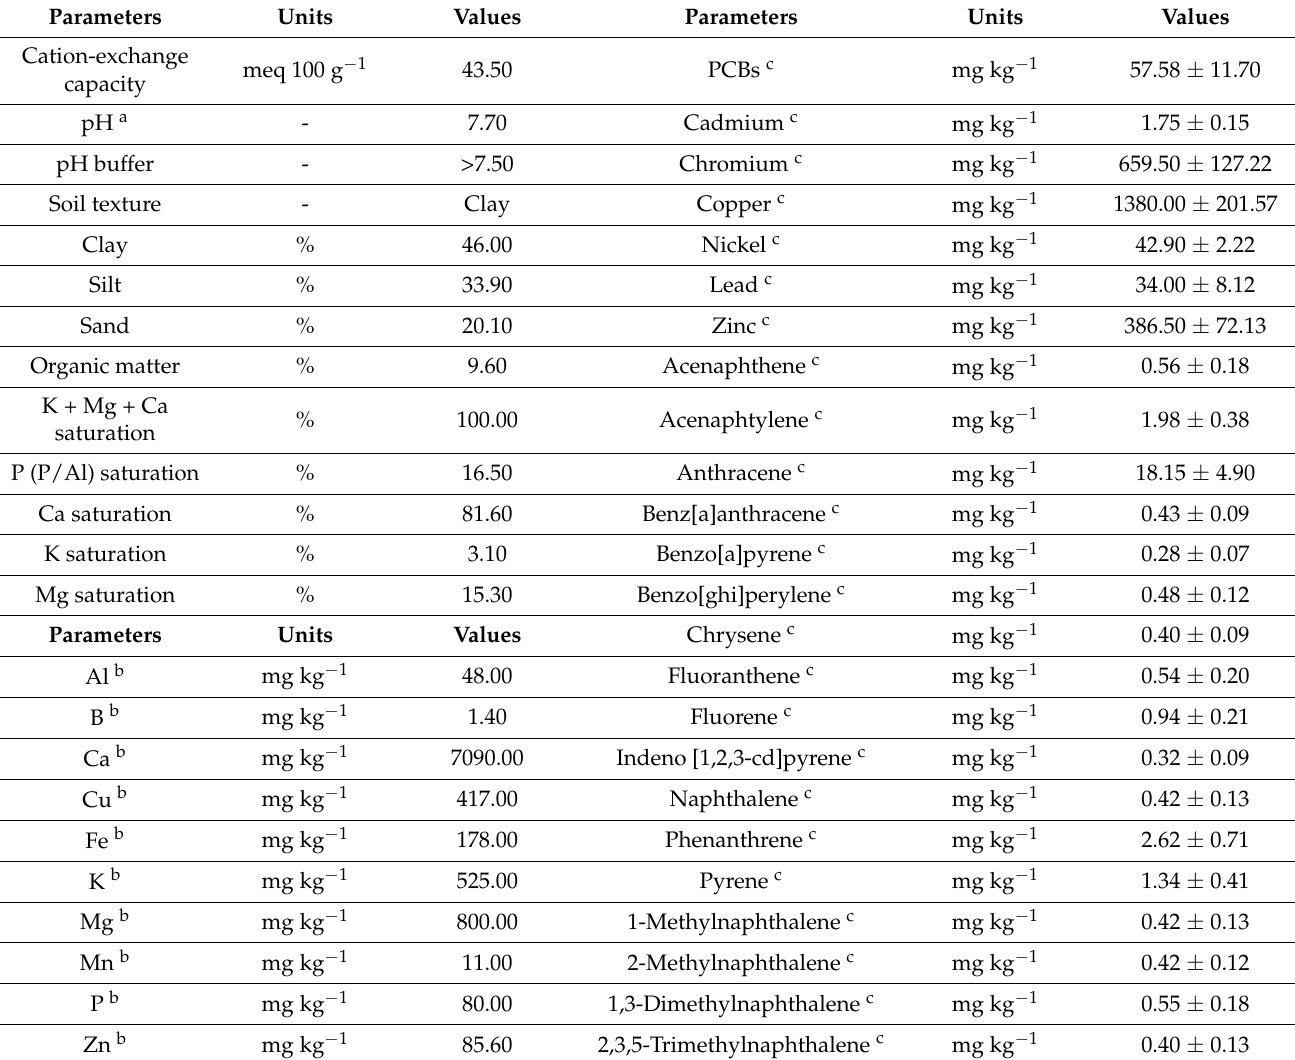
Table 1. Soil characteristics of the site in